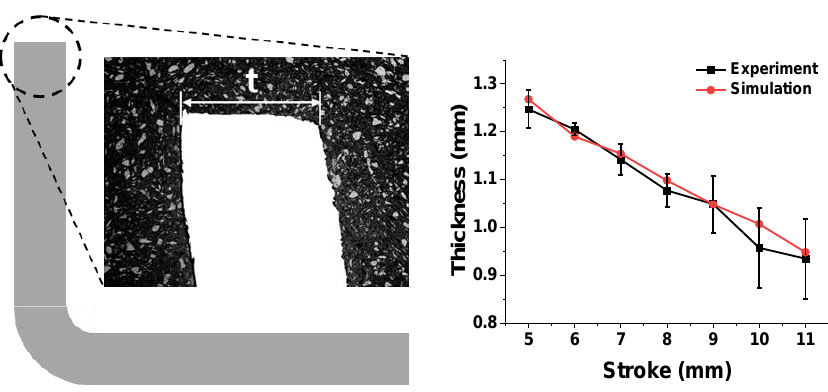
Figure 9. Change in edge thickness according to stroke.